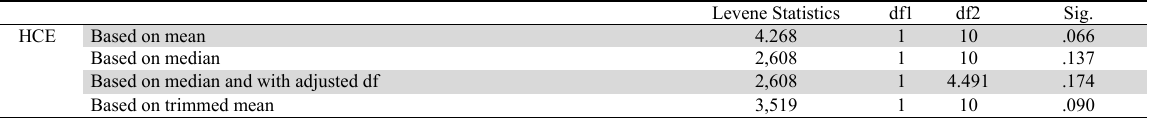
The results of Homogeneity